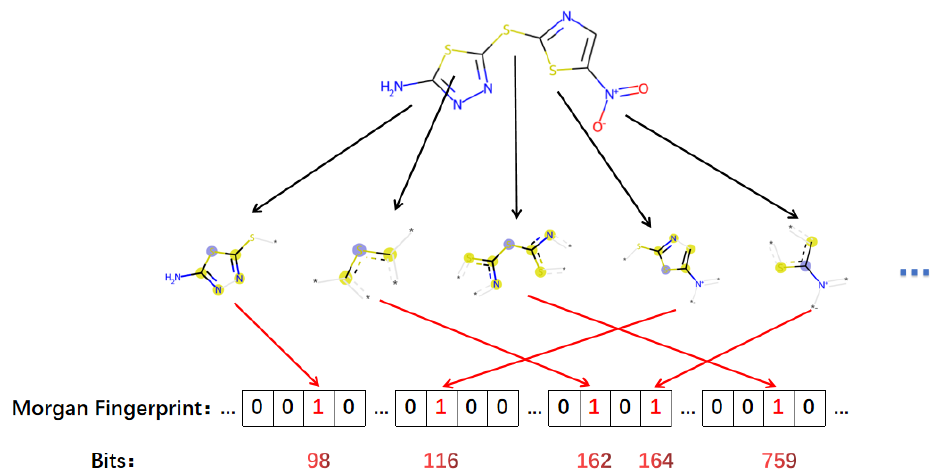
Figure 6. Schematic diagram of Morgan fingerprint generation.